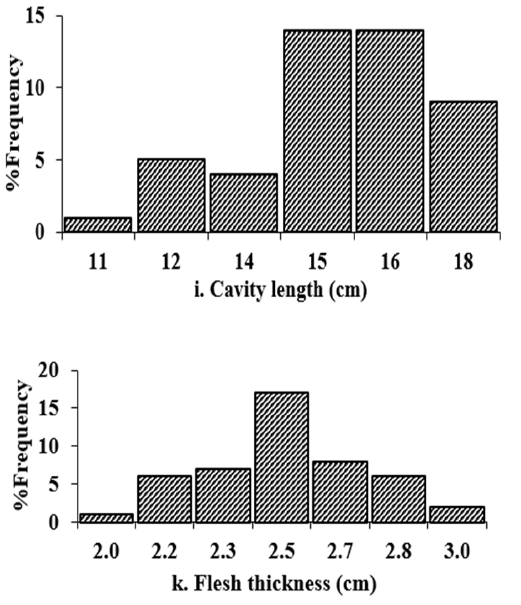
Figure 1. ( a – k ). Accumulative phenotype distributions of each trait assessed in the F5 recombinant inbred line population were collected across all four trial sites ( n = 160). Table 2. Broad sense heritability (h 2 b.s ) of key agronomic and consumer-driven fruit quality traits assessed in the F5 RIL at each environment compared to commercial RB1. Where T1 and T2 are Tablelands trial sites, and C1 and C2 are the Coastal trail